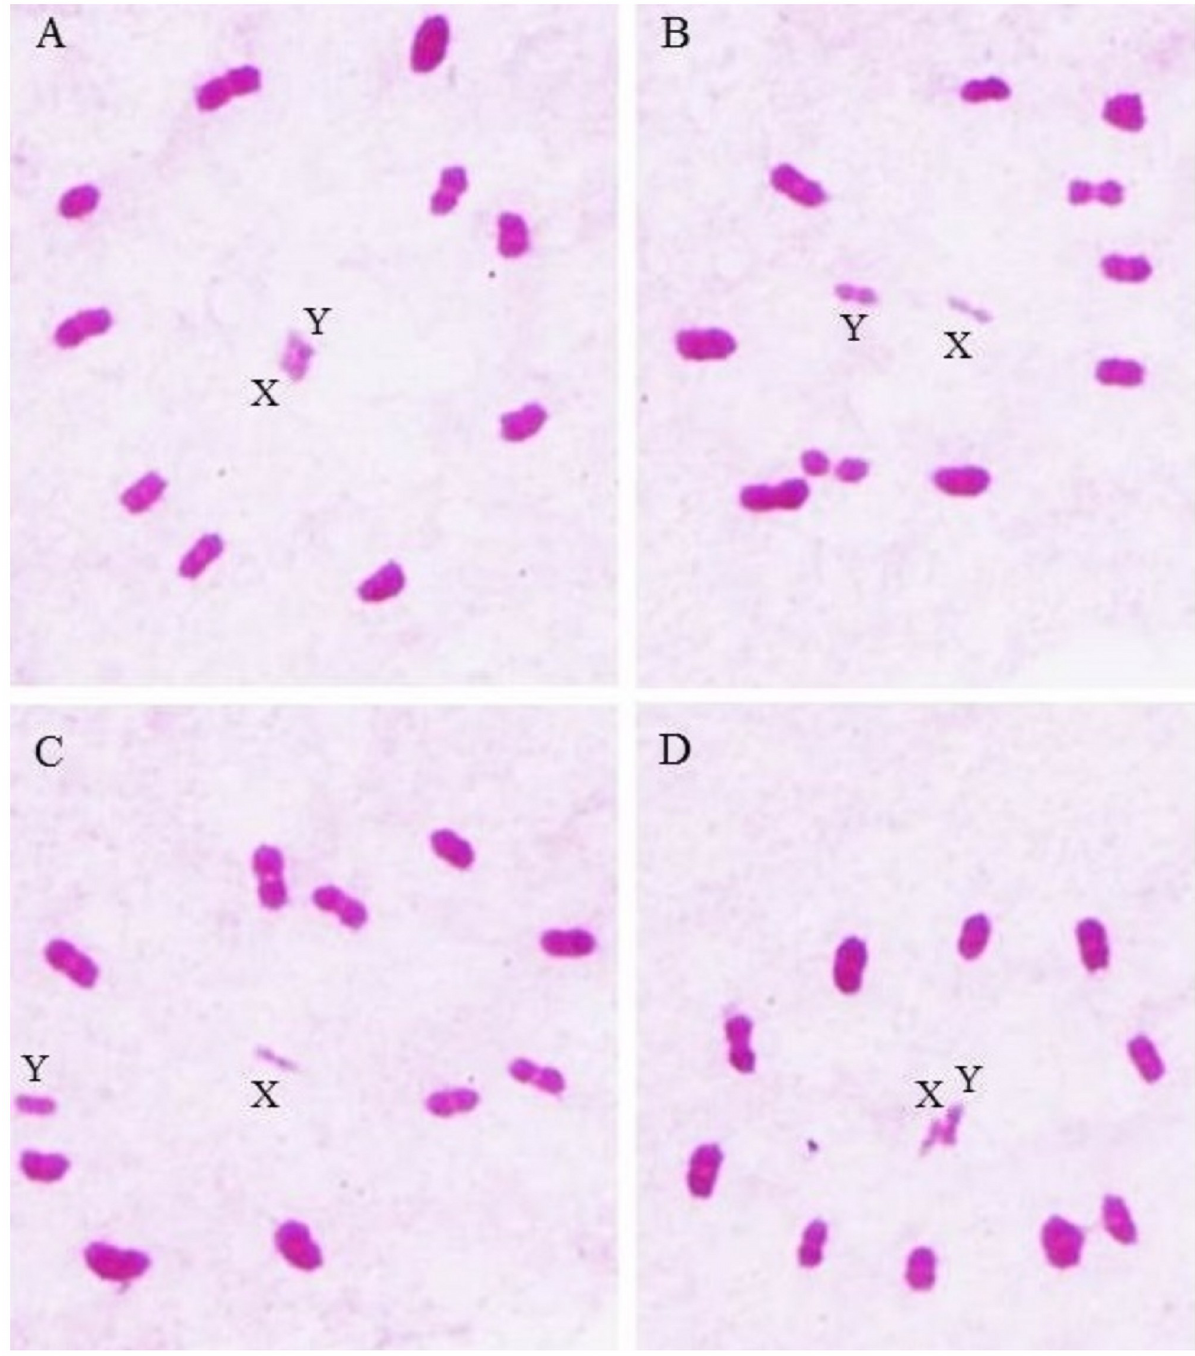
Fig 3. Metaphases I of hybrids from the cross between species of the T . brasiliensis complex: T . b . brasiliensis female x T . lenti male (A), T . b . macromelasoma female x T . lenti male (B), T . juazeirensis female x T . lenti male (C) and T . melanica female x T . lenti male (D). Note that 100% of the chromosomes were paired. X: X sex chromosome; Y: Y sex chromosome; Bar: 10 μ m.